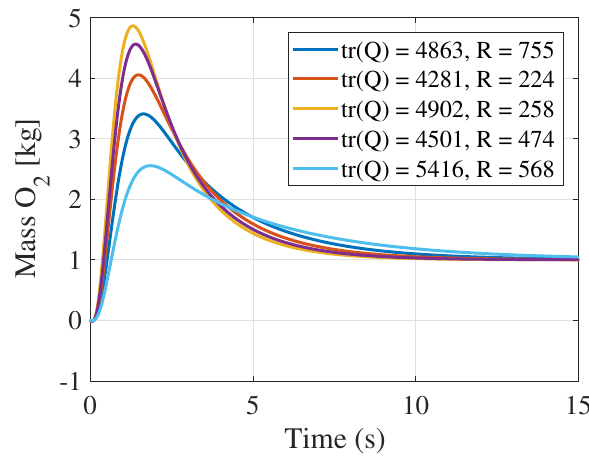
for various Q and R values. 2